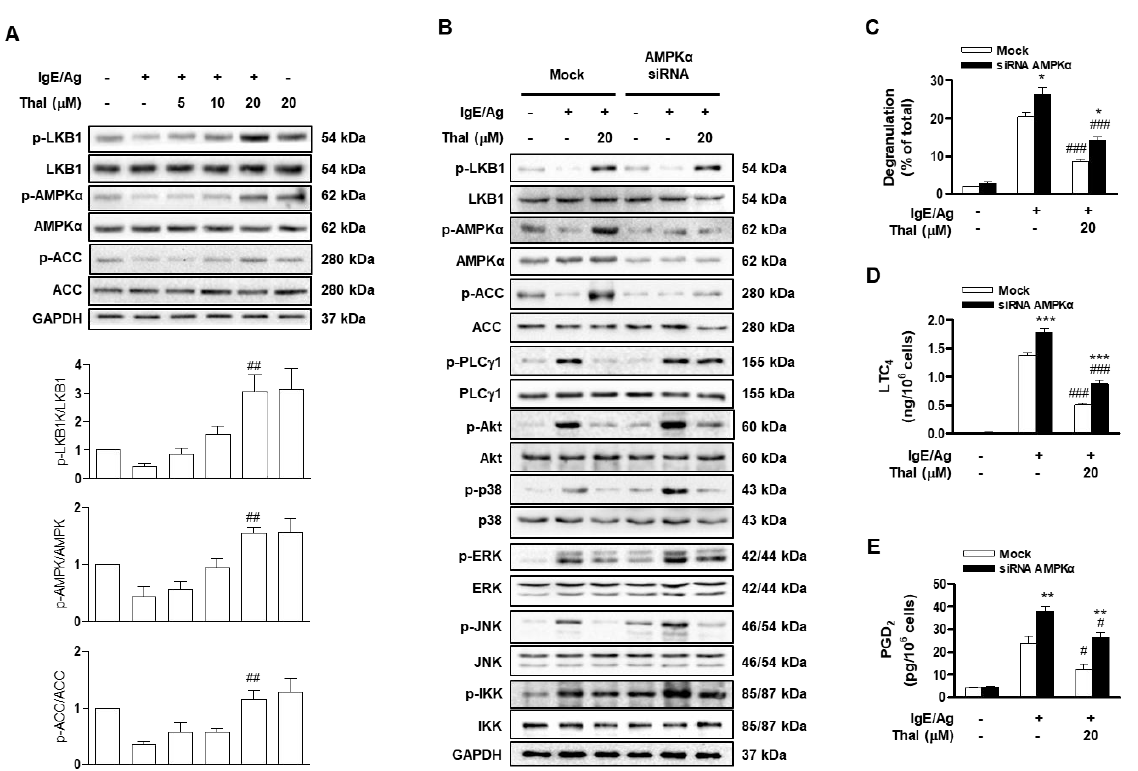
Figure 2. AMPK α knockdown decreases the inhibitory effects of thalidomide on IgE/Ag-stimulated mast cell activation. BMMCs were sensitized with anti-DNP IgE and treated with various concen- trations (5, 10, and 20 μM) of thalidomide (Thal) for 1 h ( A ) or IgE-sensitized BMMCs were treated with AMPK α siRNA or non-specific (Mock) siRNA for 48 h and then treated with 20 µ M of Thal ( B – E ) followed by stimulation with DNP-HSA (Ag) for 15 min. The levels of phosphorylated or total protein were determined by immunoblotting ( A , B ). The representative blots from three independent experiments were presented. The bar graph presents the ratio of band intensity of phosphorylated sig- naling molecules to those of the total proteins ( A ). Degranulation ( C ) and secretion of LTC 4 ( D ) and PGD 2 ( E ) were evaluated as described in the Materials and Methods section. Data represent the means ± SEM (n = 3, * p < 0.05, ** p < 0.01, and *** p < 0.001 vs. Mock in each treatment; # p < 0.05, ## p < 0.01, and ### p < 0.001 vs. IgE/Ag alone in each